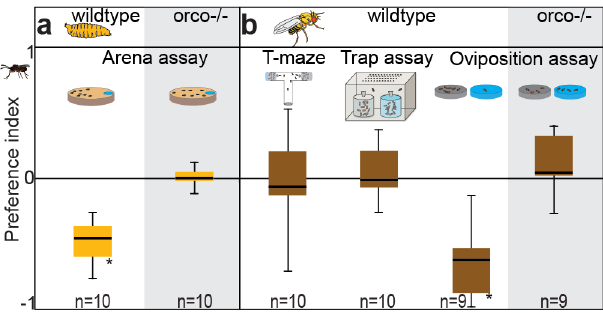
Fig 1. Larvae and ovipositing flies are repelled by parasitoid odor. ( A ) Larval choice assay and preference indices when larvae were exposed to the wash of L . boulardi . ( B ) Different choice assays (T- maze, Trap assay, Oviposition assay) for adult flies and resulting preference indices when exposed to the wash of L . boulardi . PI = (number of larvae, flies, or eggs in odor side − number in control side) / total number. Bar plots indicate minimum and maximum values (whiskers), the upper and lower quartiles (boxes) and the median values (bold black line). Deviation of the indices against zero was tested with Wilcoxon rank sum